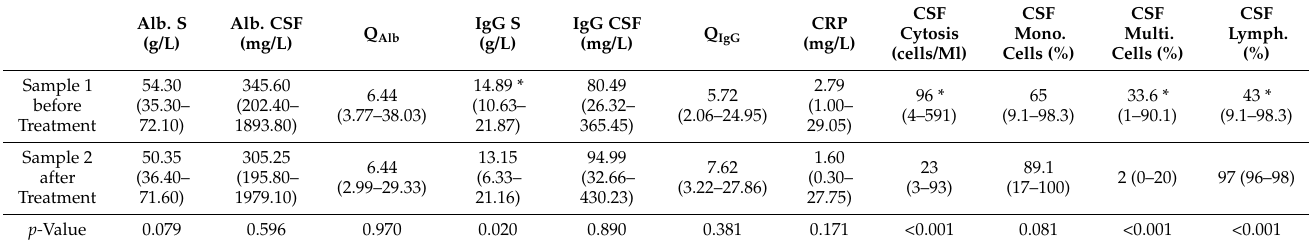
Table 2. Results of routine laboratory tests in patients with tick-borne encephalitis.